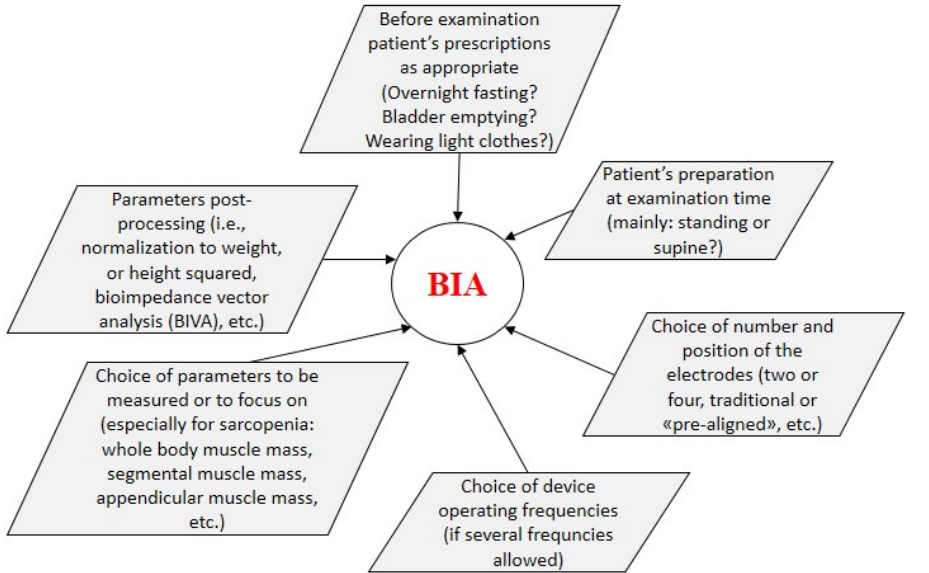
Figure 2. Methodological aspects related to BIA examination.